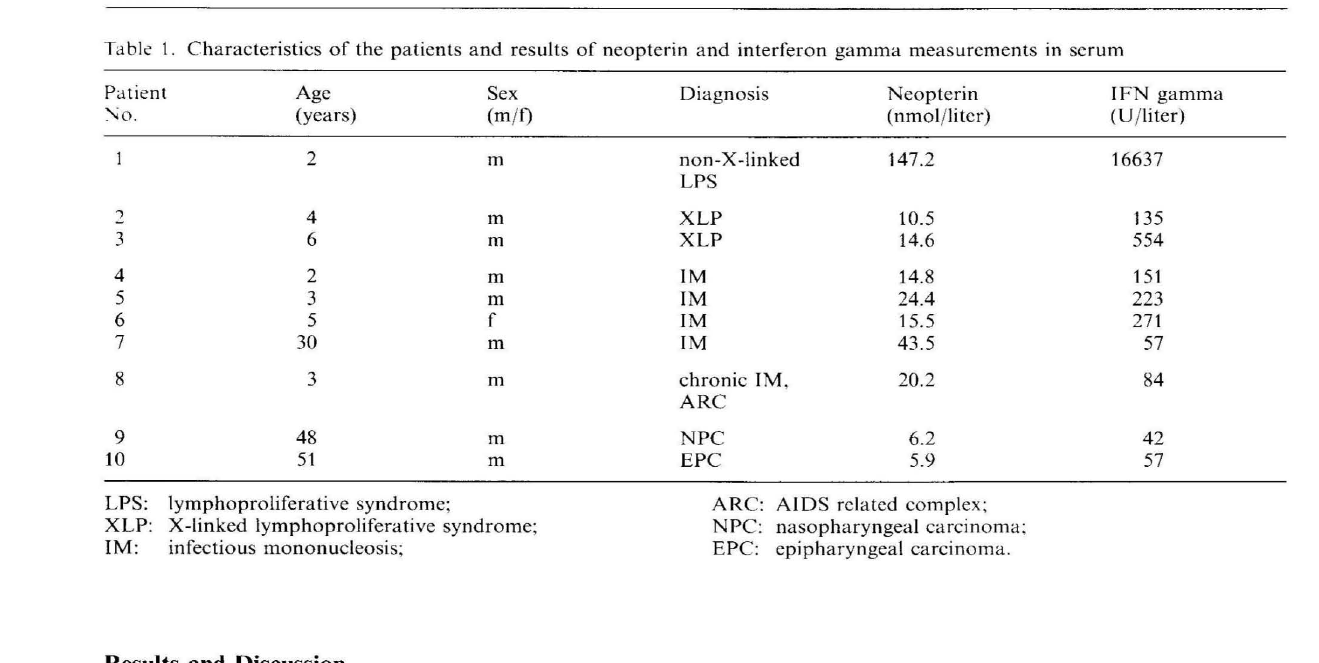
LPS: lymphoproliferative syndrome; XLP: X-linked lymphoproliferative